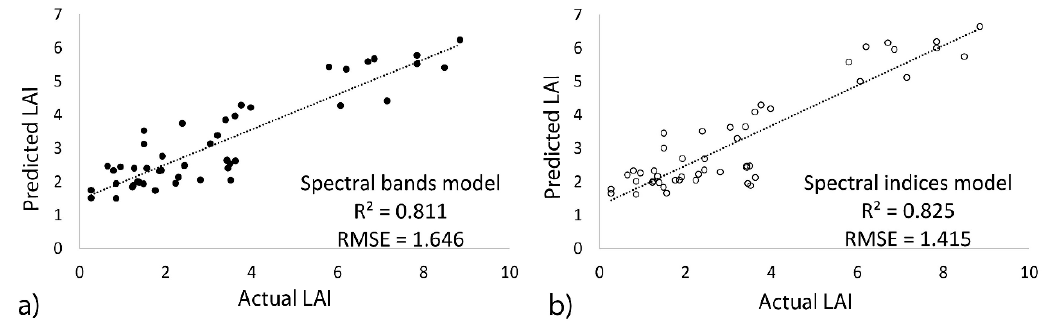
Figure 2. The relationship between the observed and predicted values of ( a ) the spectral bands model and ( b ) the spectral indices model on the full dataset.